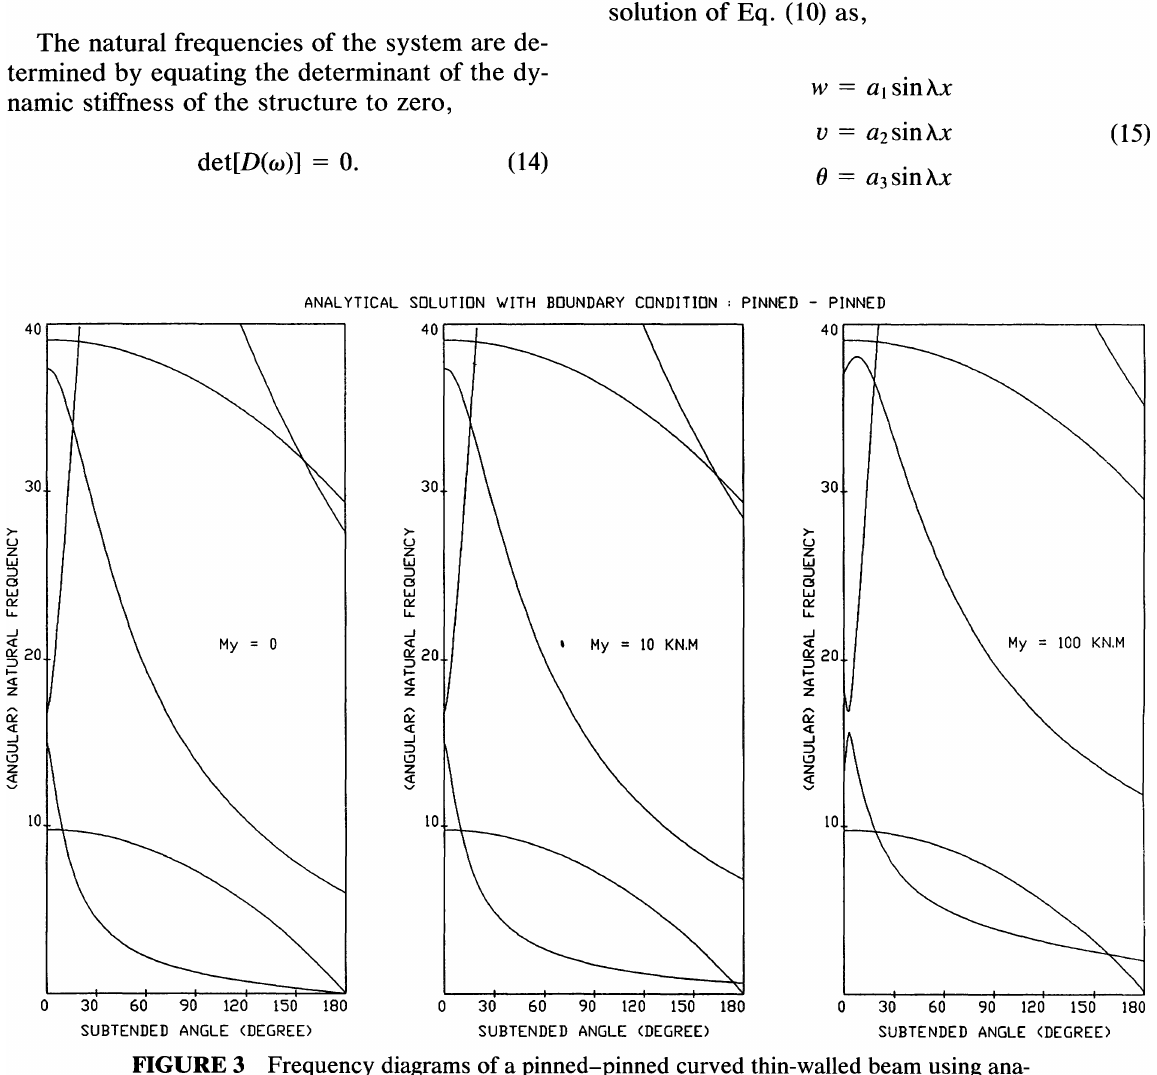
FIGURE 3 Frequency diagrams of a pinned-pinned curved thin-walled beam using ana lytical